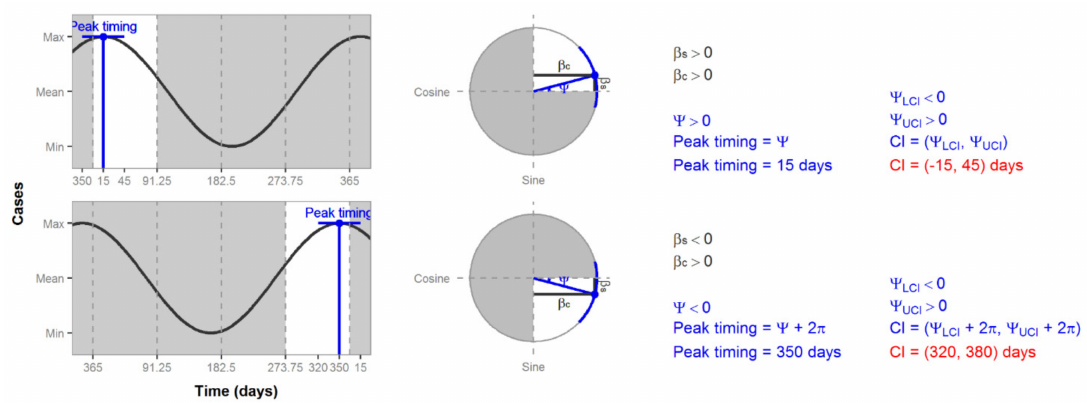
Figure 8. Plots of peak timing CIs. Values that fall outside of the shown year range (1 to 365 days) are highlighted in